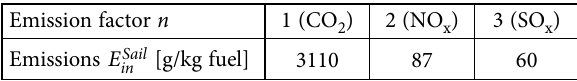
Table 1. Reference values of emission factors while sailing